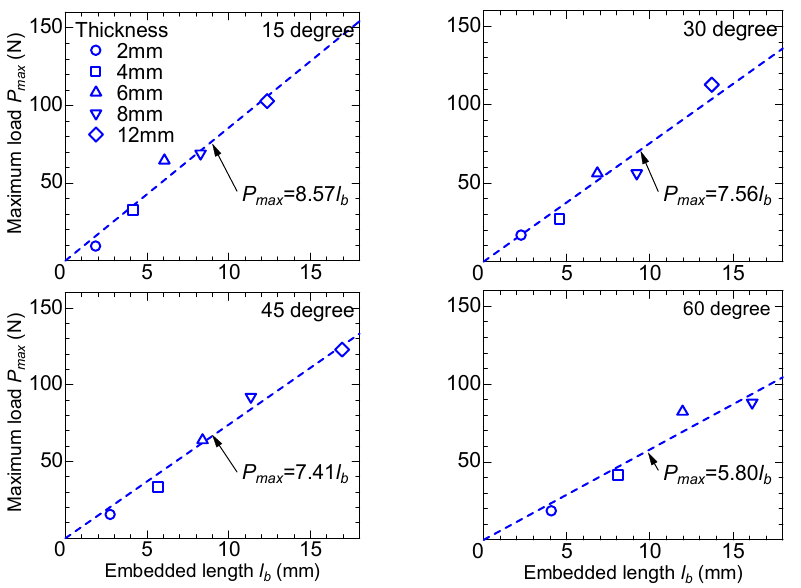
Figure 9. Maximum load versus embedded length (no-inclined angle).